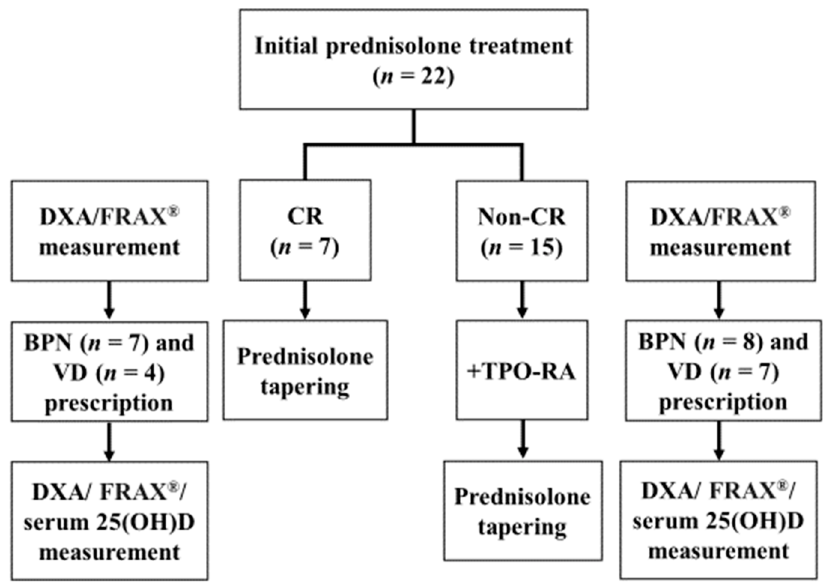
Figure 1. Treatment charts of 22 patients with immune thrombocytopenia. Seven patients achieved a complete response (CR). Fifteen patients had a platelet count <30 × 10 9 /L, all of whom